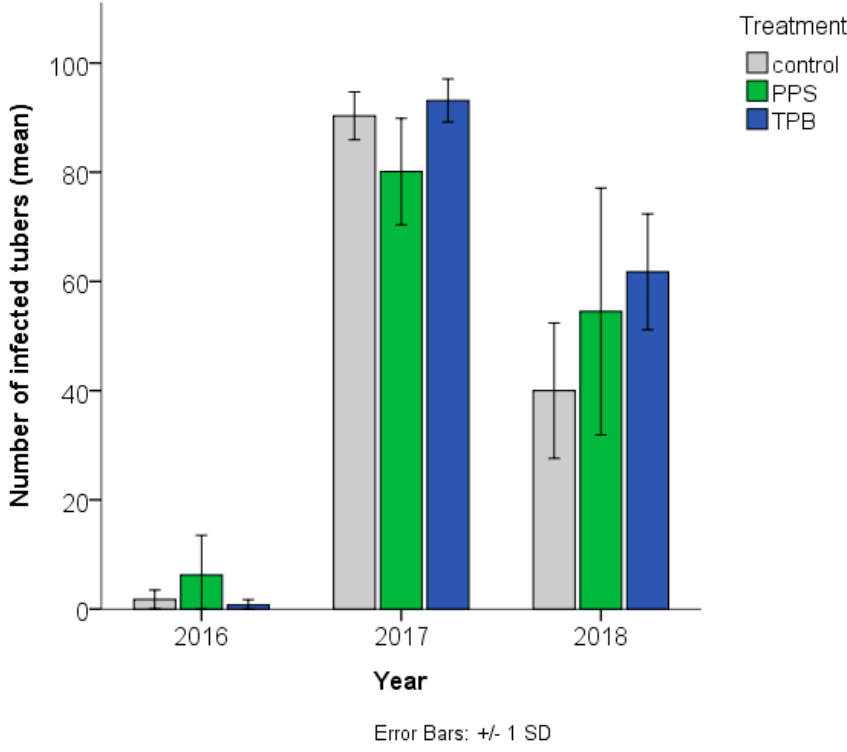
Figure 1. Number (means + standard deviation) of Streptomyces sp.-infected potato tubers in samples in the three different treatments, in three consecutive years (average of samples). Treaments: Control (Without any microbial treatments), PPS contains Pseudomonas protegens , Pseudomonas jessenii , and Stenotrophomonas maltophilia ; TPB contains Trichoderma atroviride , Pseudomonas putida , and Bacillus subtilis. n = 4 in each group.